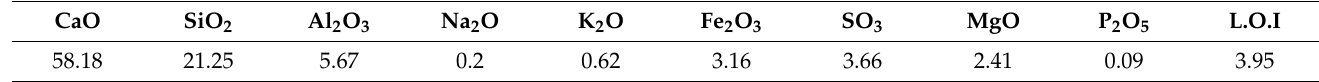
Table 1. Chemical composition of cement